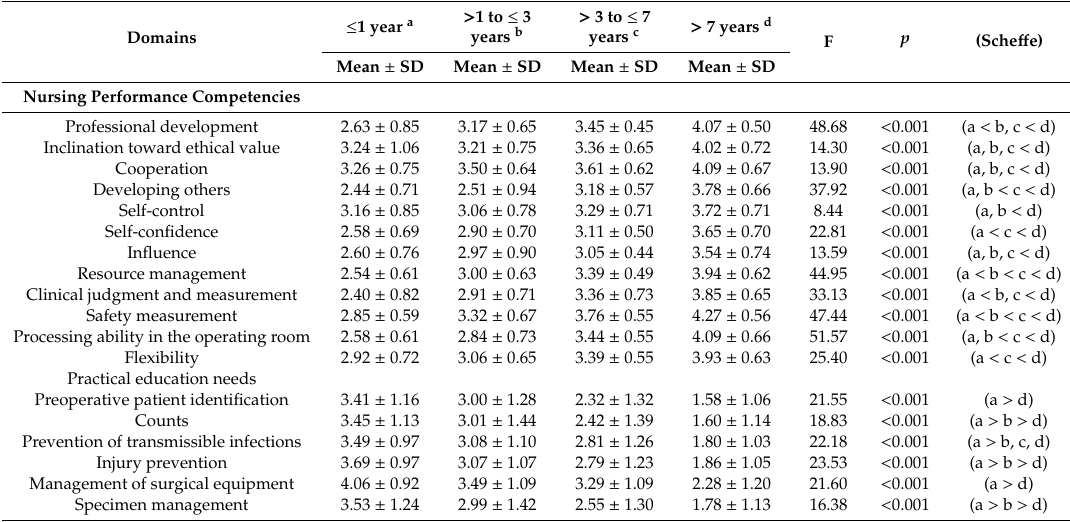
Table 3. Domains of nursing performance competencies and practical education needs by clinical career ( n =